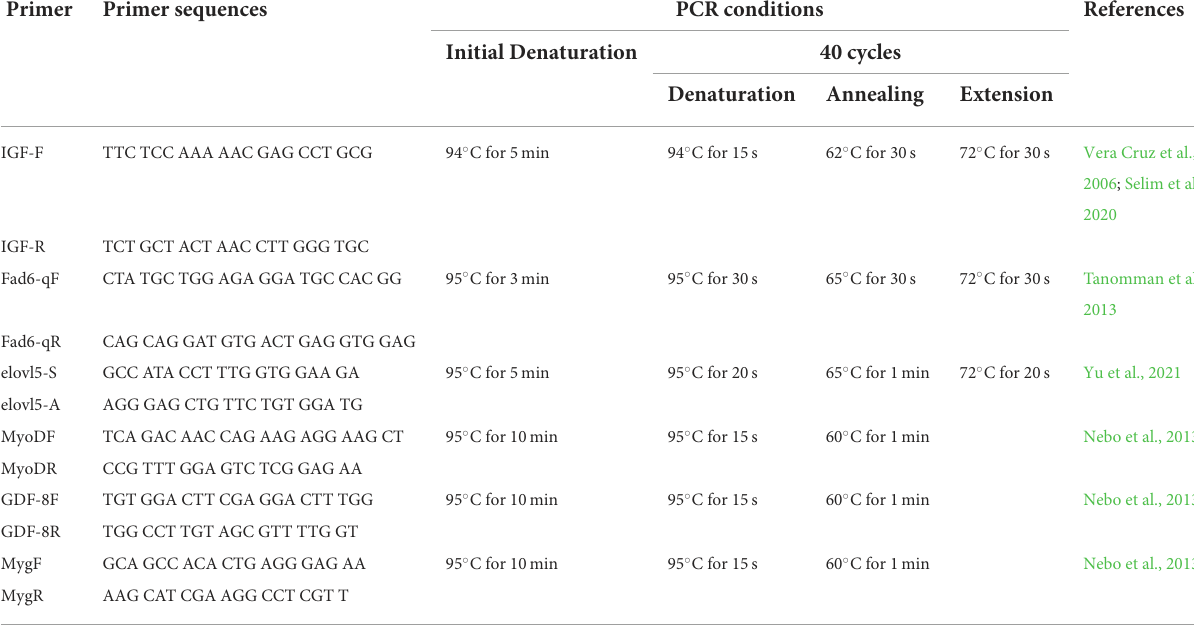
TABLE 3 Primers and conditions used in real-time reverse transcription polymerase chain reaction for muscle and liver genes.